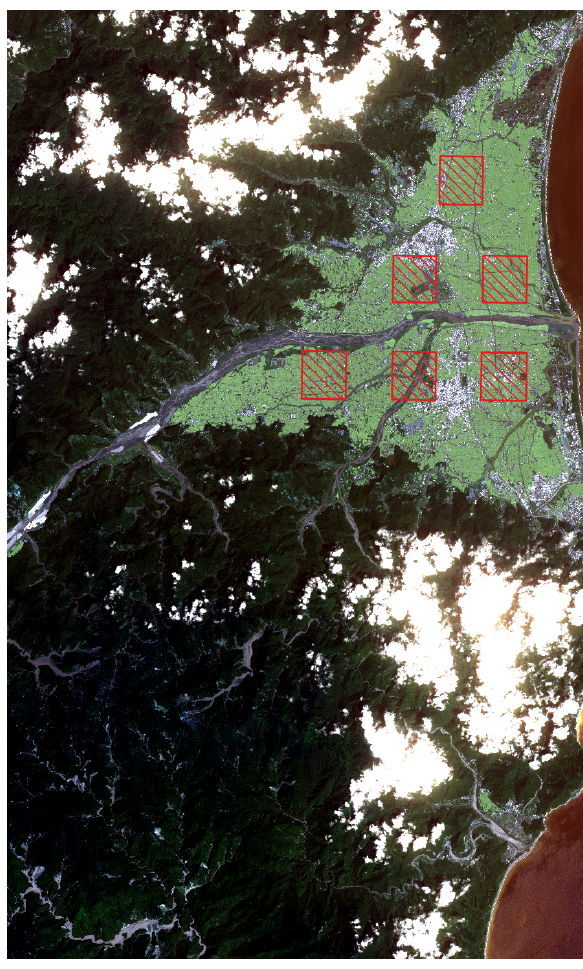
Figure 14. Crop farmland test data sampling.